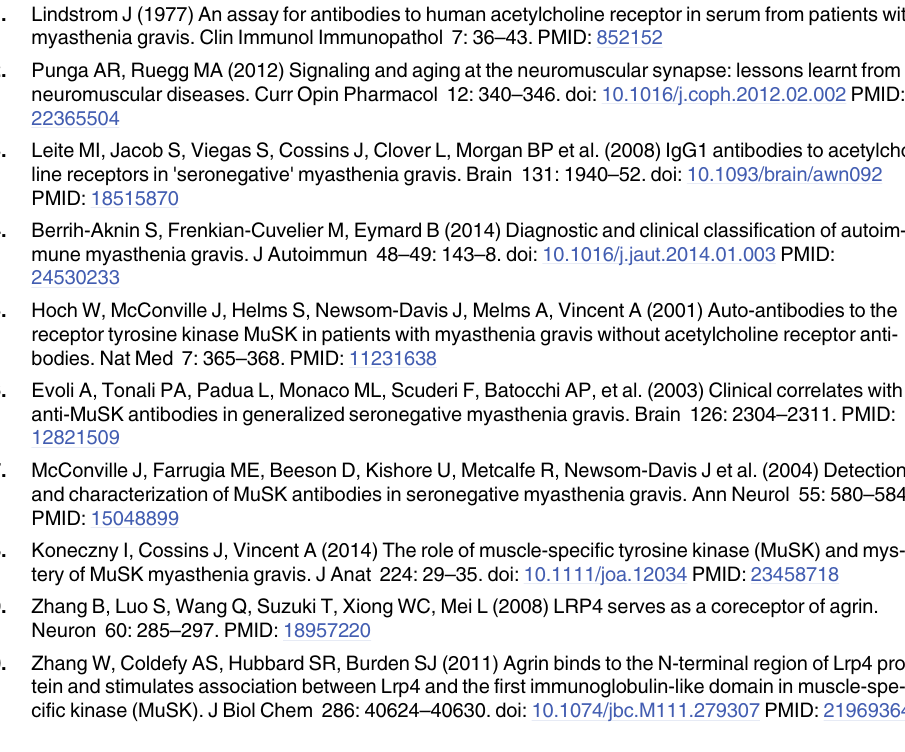
S1 Fig. Cell based assay for LRP4 antibody detection. For immunofluorescence detection of LRP4fl-transfected cells, un-transfected (A) and transfected (B) HEK293T cells were fixed with methanol, washed three times with cold PBS, blocked for10 min at room temperature with PBS/BSA 5% and incubated at 4°C with LRP4-positive patient serum at 1:100 dilution in PBS/ BSA 0.1% (PBS-BSA), for 30 min. FITC conjugated anti-human IgG goat antiserum (AXA Diagnostics, Italy) were added at a 1:100 dilution in PBS-BSA and the samples incubated for 30 min at 4°C. Cells were examined on a Nikon Eclipse E600 fluorescence